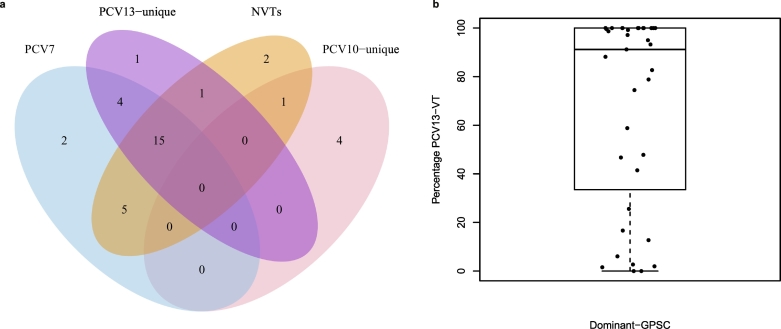
PCV composition of dominant Global Pneumococcal Sequence Clusters (GPSCs).(A) Venn diagram of the number of dominant-GPSCs (n = 35) in which combinations of PCV7 VTs, PCV10/13 unique VTs and NVTs were observed in the same GPSC pre-PCV. Over one-third (15/35) of the dominant-GPSCs expressed both PCV7 (blue), PCV13-unique (purple) and NVT (orange) pre-PCV, shown in the overlap. Whilst 24/35 dominant-GPSCs had at least one isolate expressing an NVT pre-PCV (orange area). (B) PCV13 VT contribution to GPSCs pre-PCV. Each point represents a dominant-GPSC (n = 35) and the percentage of its pre-PCV isolates expressing PCV13-VTs, with boxplot of minimum, first quartile, median, third quartile, and maximum values. (For interpretation of the references to colour in this figure legend, the reader is referred to the web version of this article.)